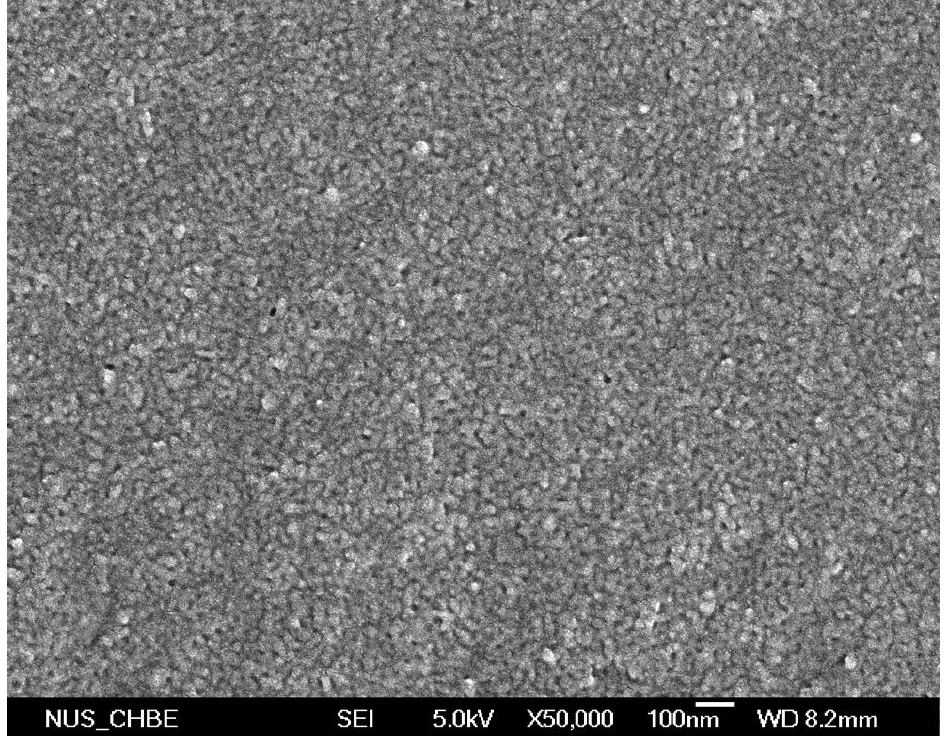
Figure A2. FE-SEM images of cross-linked diblock A50G4S-10 membrane (magnification 100,000 × ).